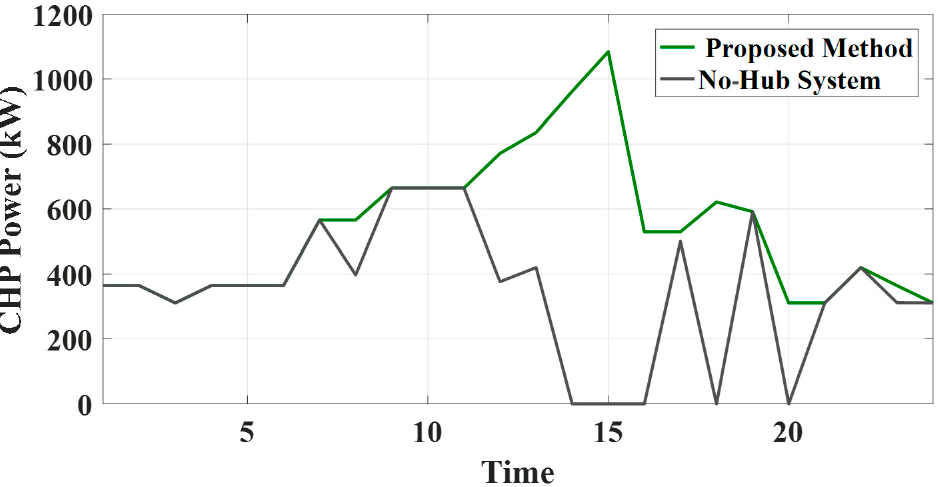
Figure 8. The CHP power for two methods: (1) proposal (2) no hub.